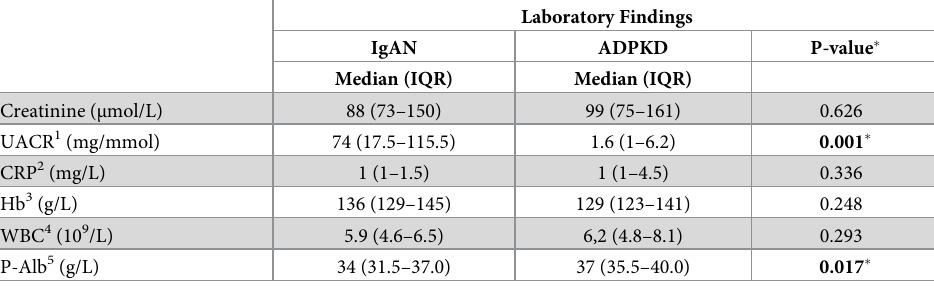
Table 2. Laboratory data for blood parameters.